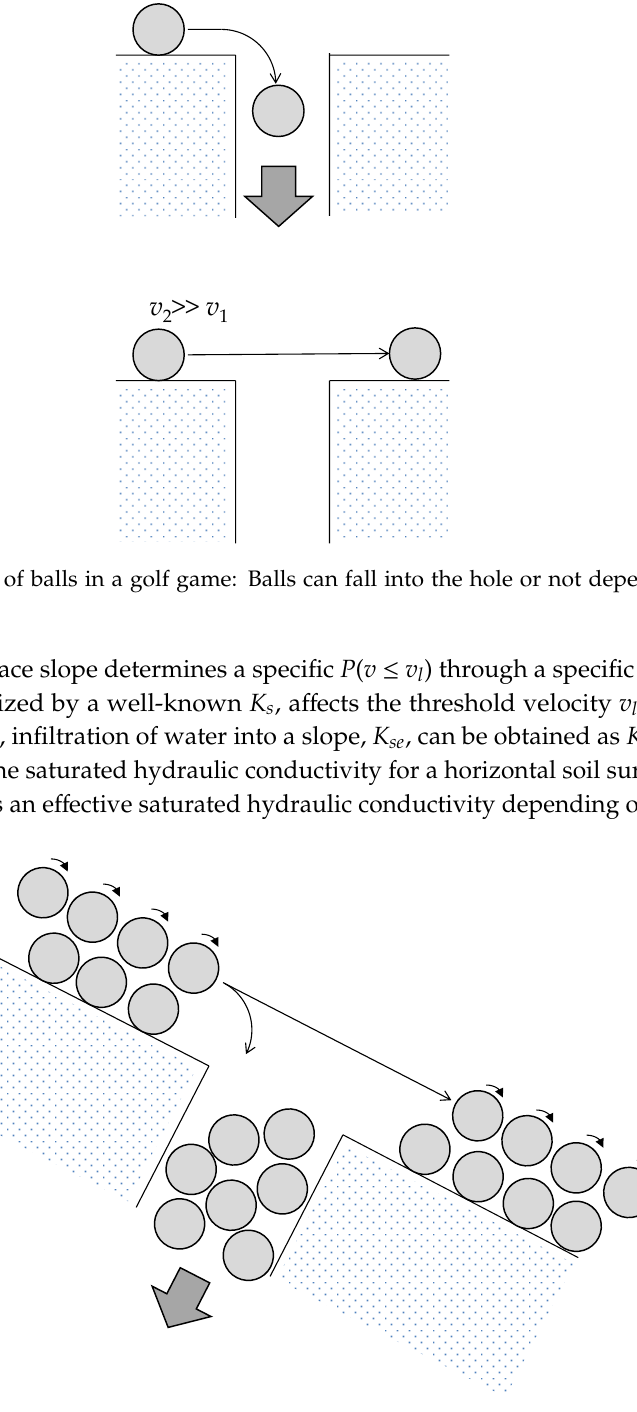
Figure 3. Soil surface with significant slope and “particles” characterized by various velocities.